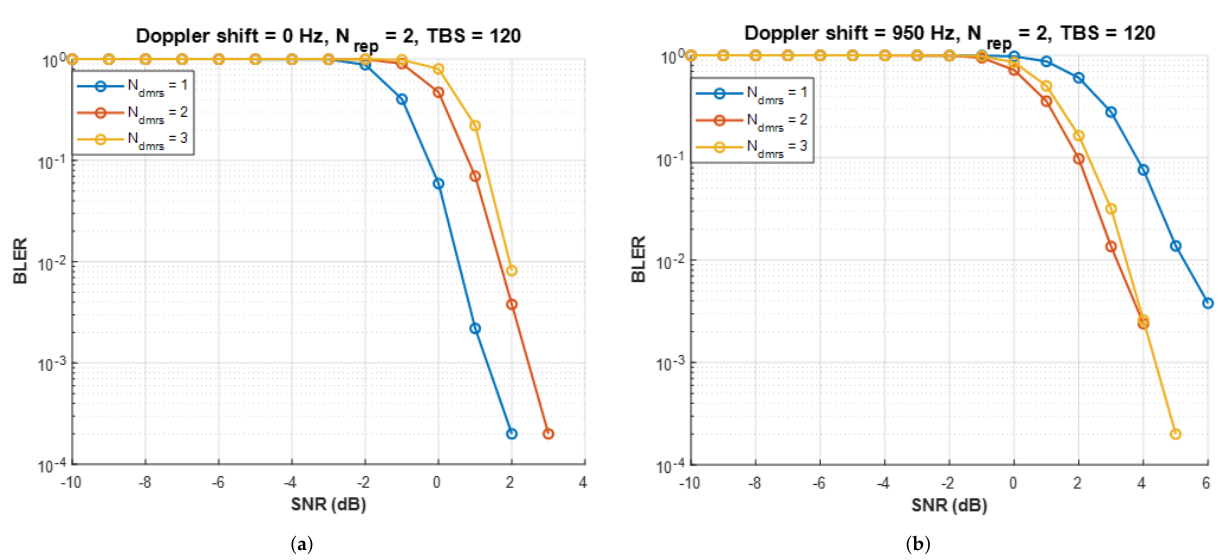
Figure 11. Uplink transmission BLER result for varying numbers of DMRS symbols. ( a ) Doppler shift = 0 Hz, ( b ) Doppler shift = 950